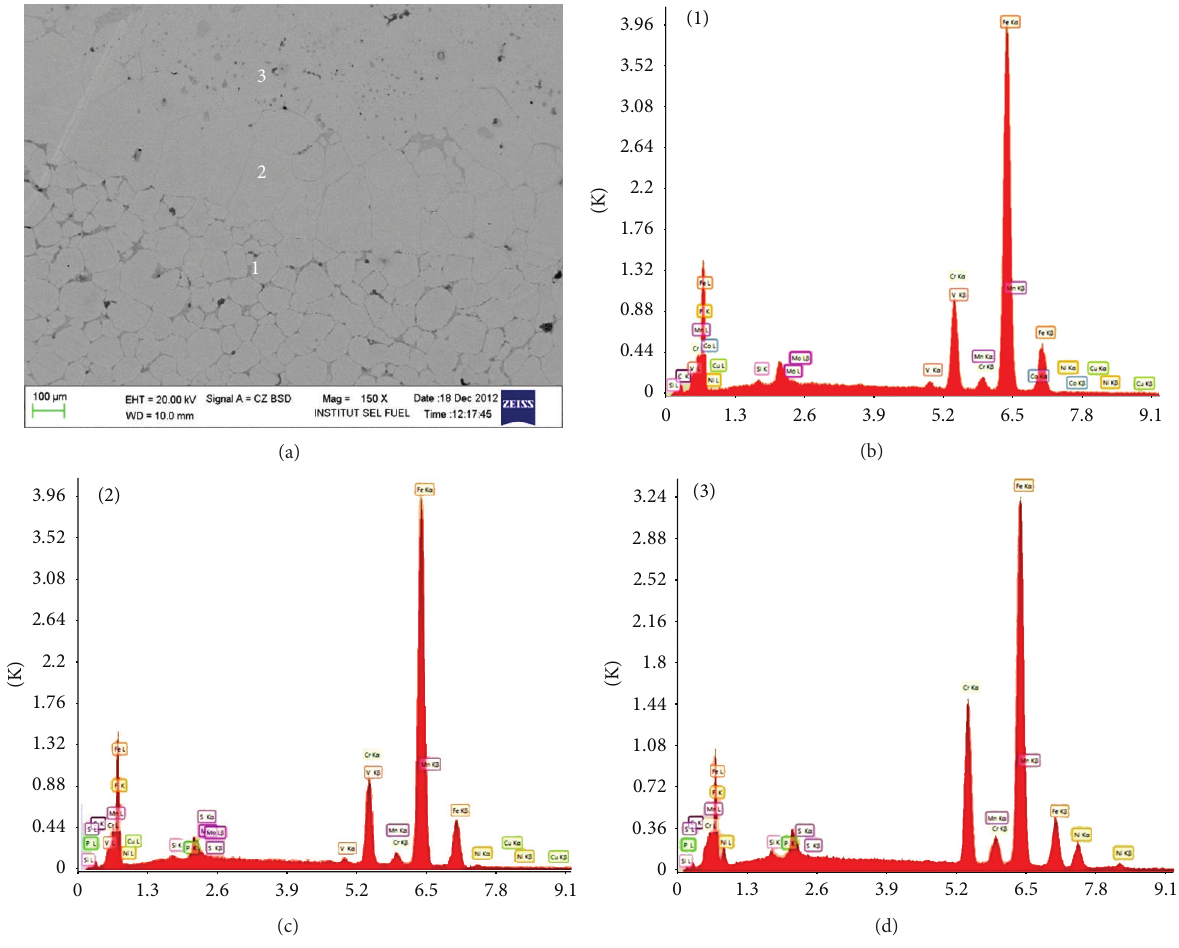
Figure 10: SEM micrograph of joining compound and EDX analysis at (point 1) AISI D2, (point 2) diffusion zone, and (point 3) 304 stainless steel.